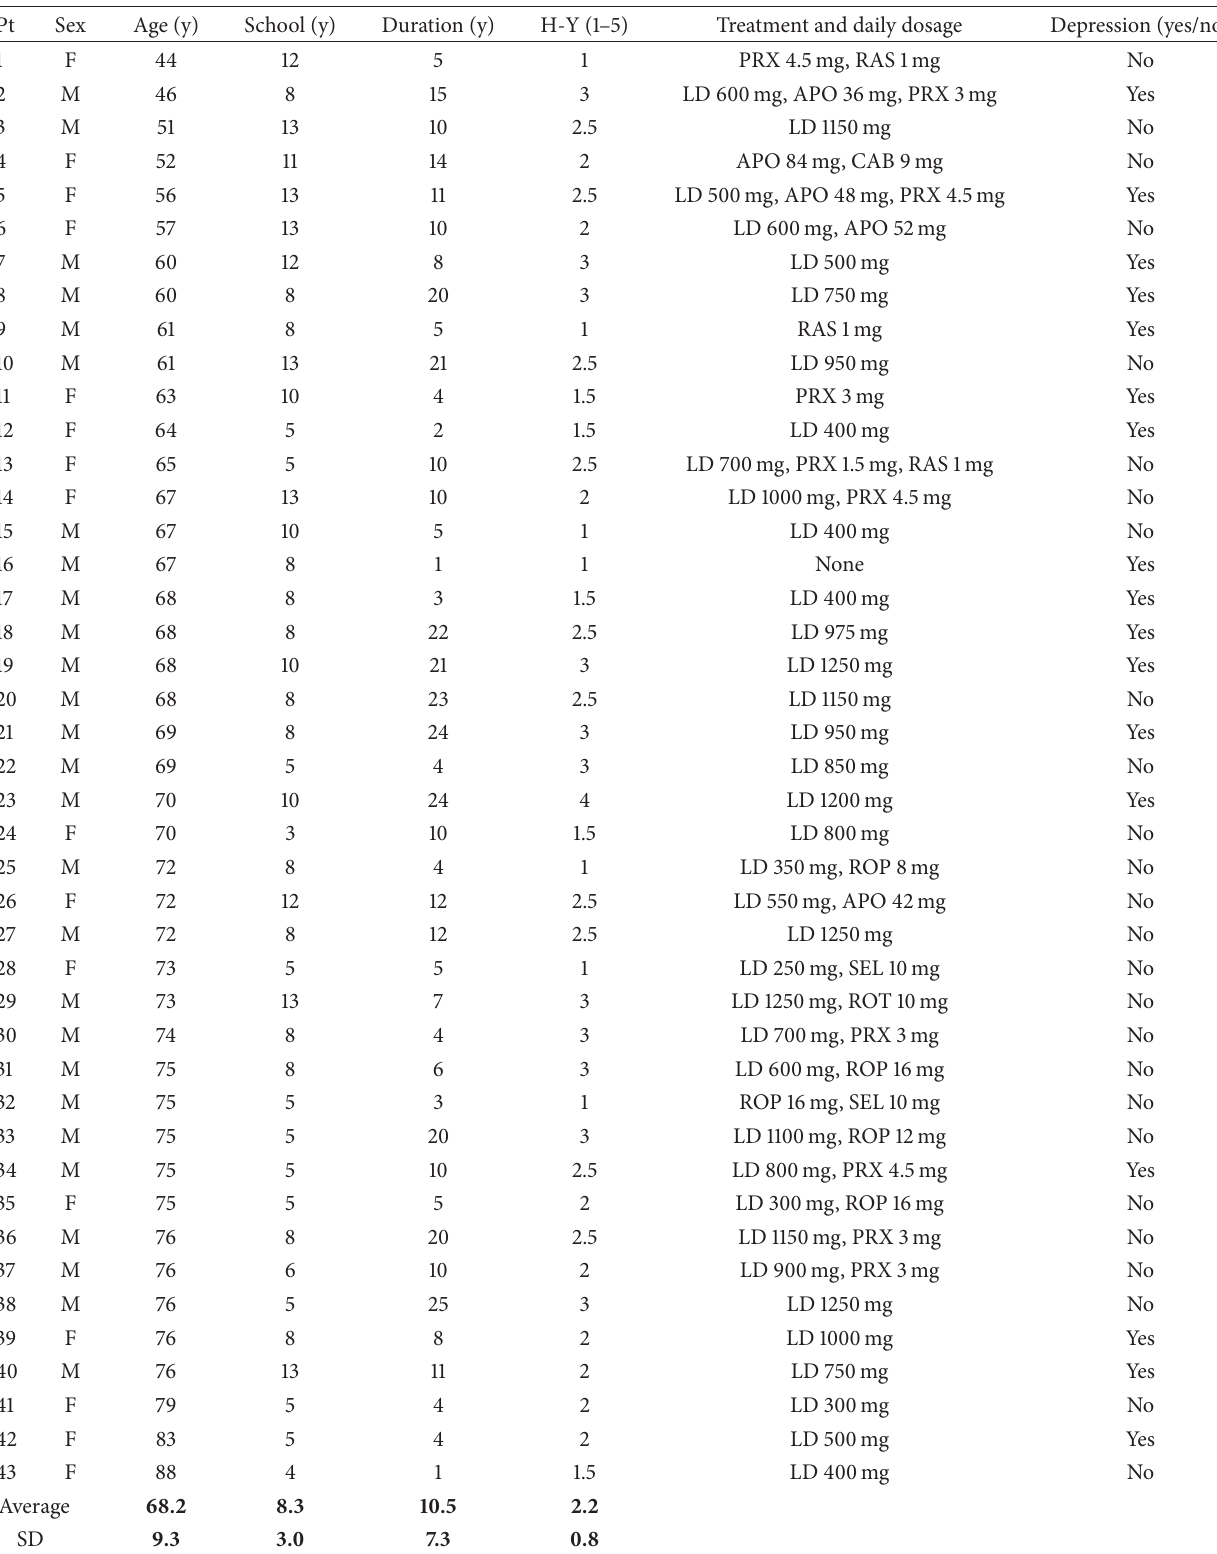
Table 1: Demographic and clinical characteristics of the